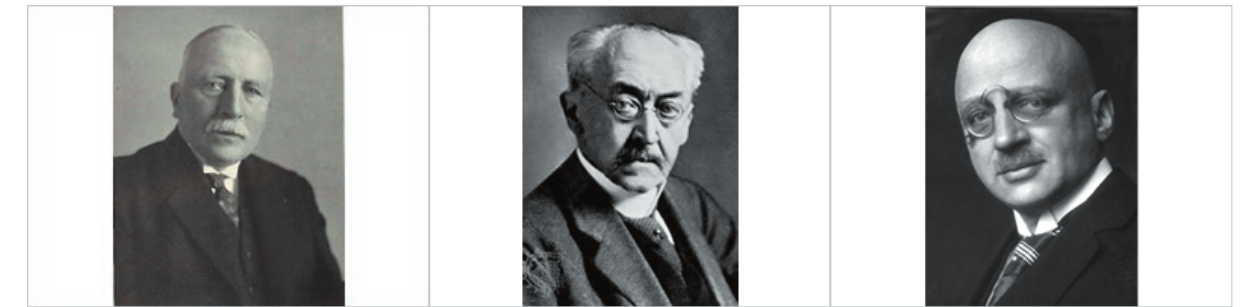
Figure 2. Left , Friedrich Schmidt-Ott, President of the Notgemeinschaft from 1920 to 1934; Middle , Adolf von Harnack; Right , Fritz